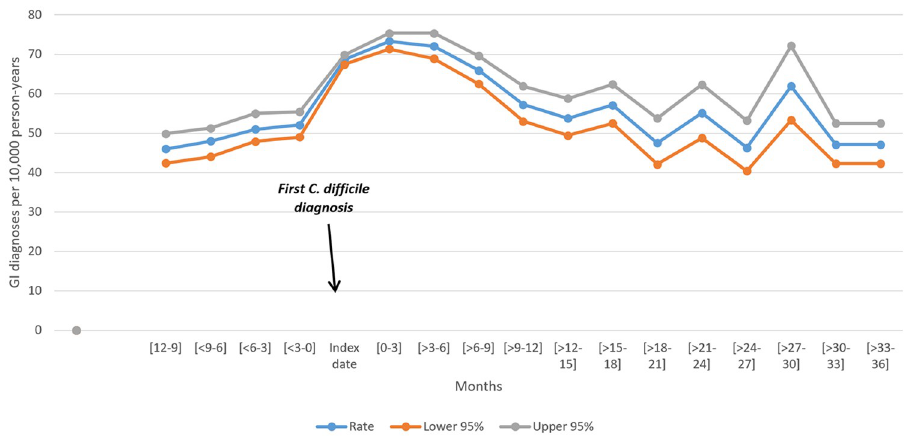
Fig 2. Unadjusted rate per 10,000 person-years for gastrointestinal diagnoses before and after first Clostridium difficile diagnosis.